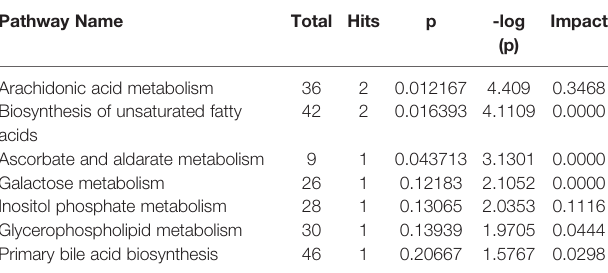
TABLE 4 | The metabolic pathways that in fl uenced by BZYQD in loperamide- treated rats.